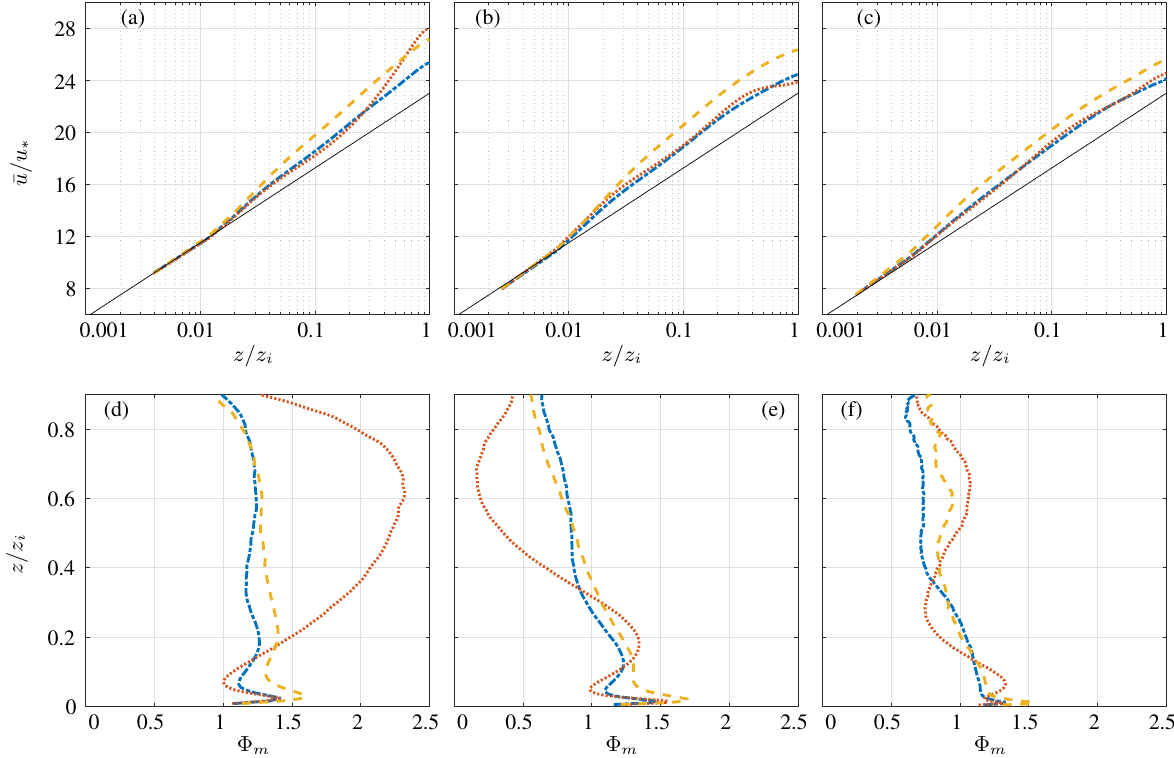
Figure 7. Top panels represent the plots of the non-dimensional mean streamwise velocity profile for (a) the 128 3 case, (b) the 192 3 case, and (c) the 256 3 case. Bottom panels represent the mean streamwise velocity gradient for (d) the 128 3 case, (e) the 192 3 case, and (f) the 256 3 case. The lines represent the three different dealiasing methods: the 3 / 2 rule as the blue dot–dashed line, the FT method as the red dotted line, and the FS method as the yellow dashed line. The solid line represents the ideal log–law